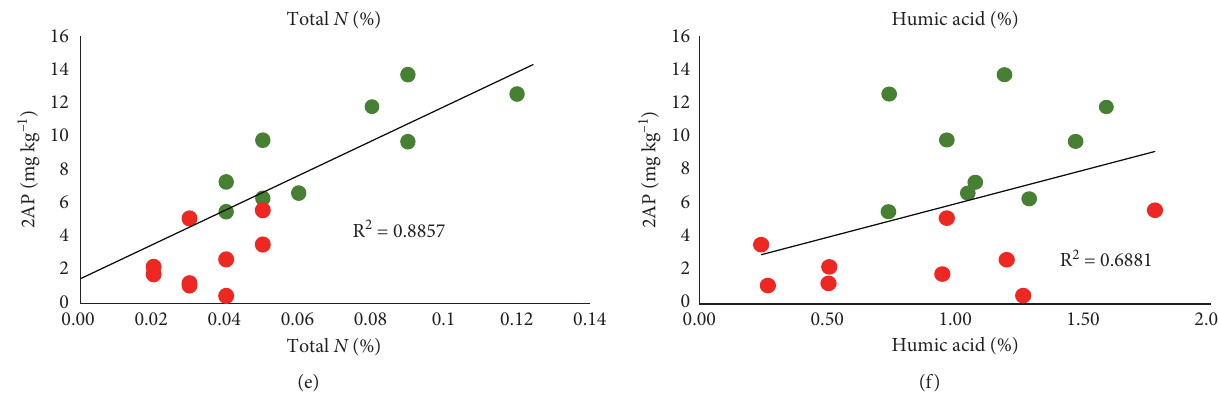
Figure 10: The amount of 2-acetyl-1-pyrroline (2AP) content in Khao Dawk Mali 105 (KDML105) rice grains as affected by soil organic matter (SOM) (a), total nitrogen (TN) (b), and humic acid (HA) (c) and their relationship with 2AP (d e, f). Note: ORF � organic rice farming; CRF � conventional rice farming.